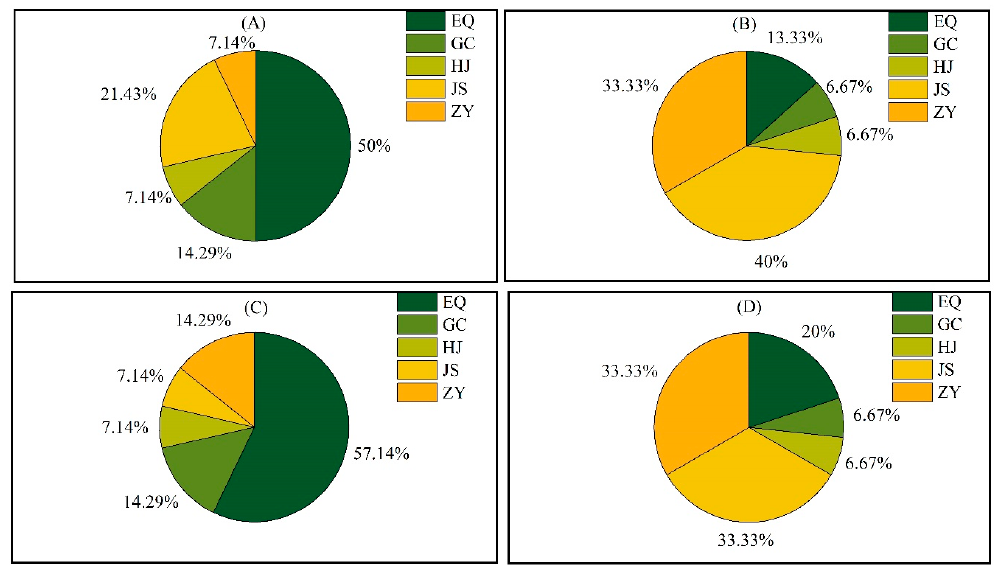
Figure 5. ( A ) Precipitation center of rain in 1971–1998, ( B ) Precipitation center of rain in 1999–2012, ( C ) Precipitation center of heavy rain in 1971–1998, ( D ) Precipitation center of heavy rain in 1999–2012. From 1971 to 1998, most of the precipitation was concentrated in EQ, where about 50 % of rain and heavy rain occurred. The main factor affecting the spatial distribution of precipitation during this period was the natural geographical conditions due to the low level of urban development. The average slope of EQ is 3.89°, which is the largest topographic fluctuation area in Zhengzhou, providing conditions for the formation of precipitation (Figure 6A).